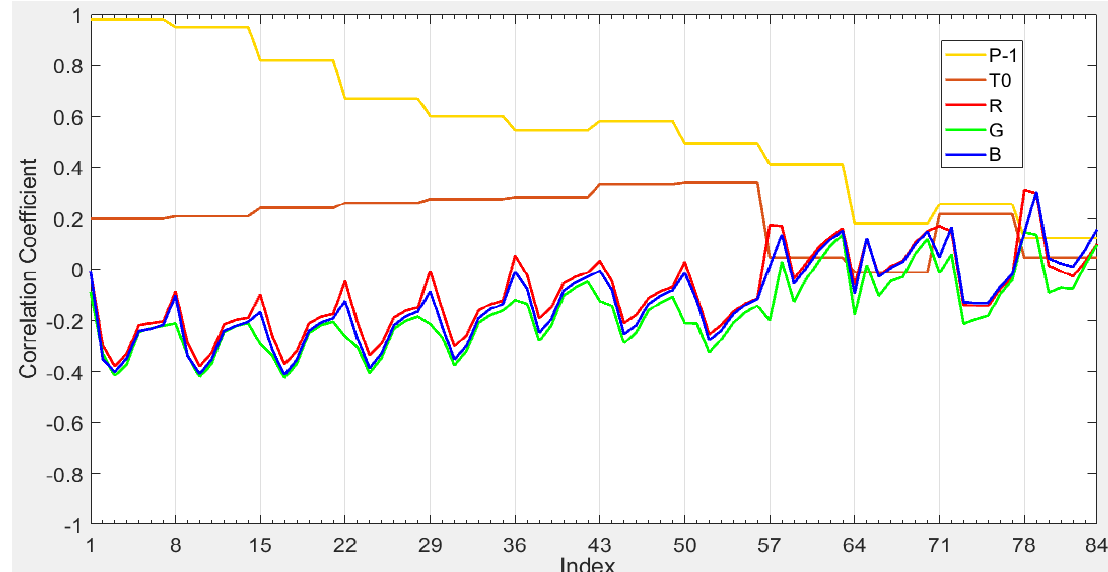
Figure 8. Correlation between P 0 and the evaluated variables.